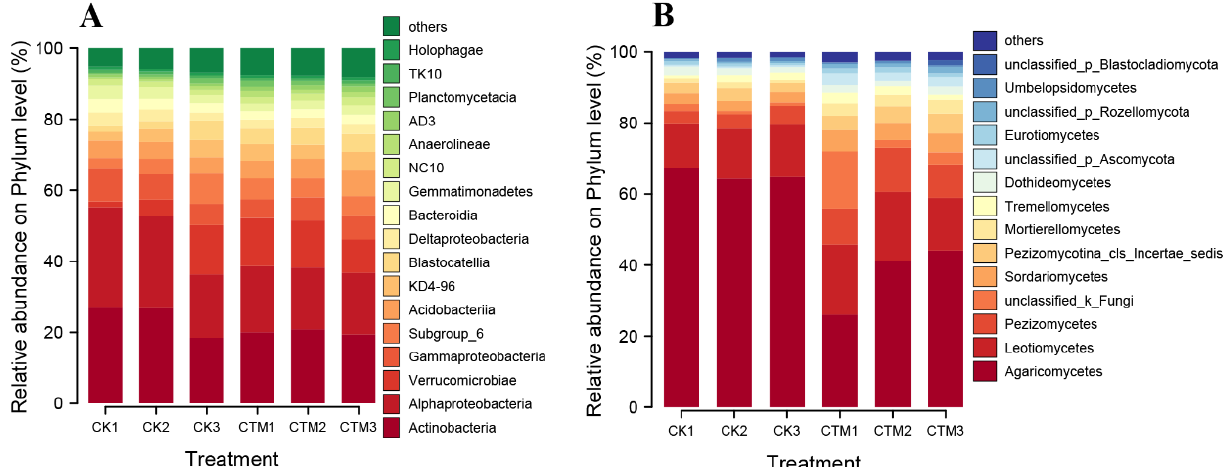
Figure 4. The relative abundance of soil bacterial ( A ) and fungal ( B ) communities at the class level in an L. gmelinii plantation after crop tree management.